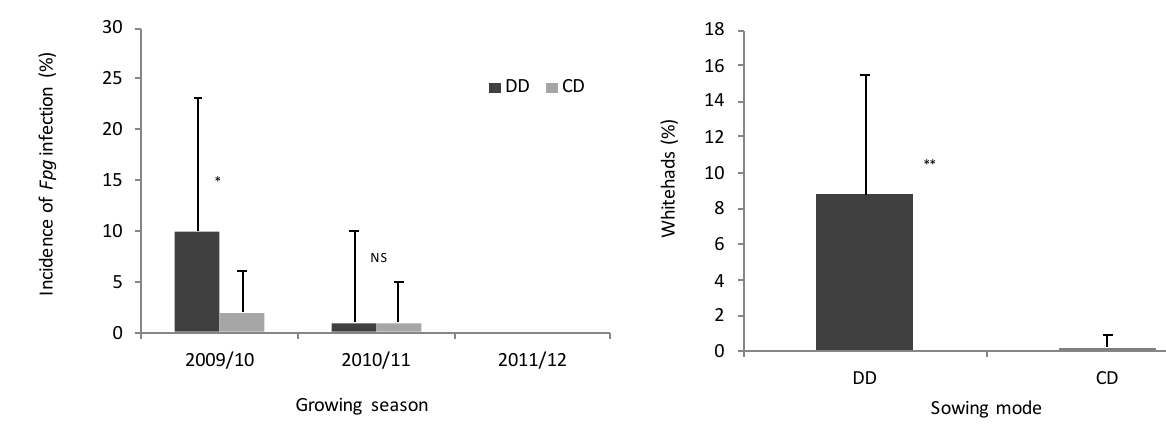
Figure 3. Mean proportions of whiteheads in durum wheat for dif- ferent sowing methods (DD vs CD) during the 2010/11 growing season. Error bars are 2 × standard deviations. **: highly significant difference ( P < 0.01) according to Student